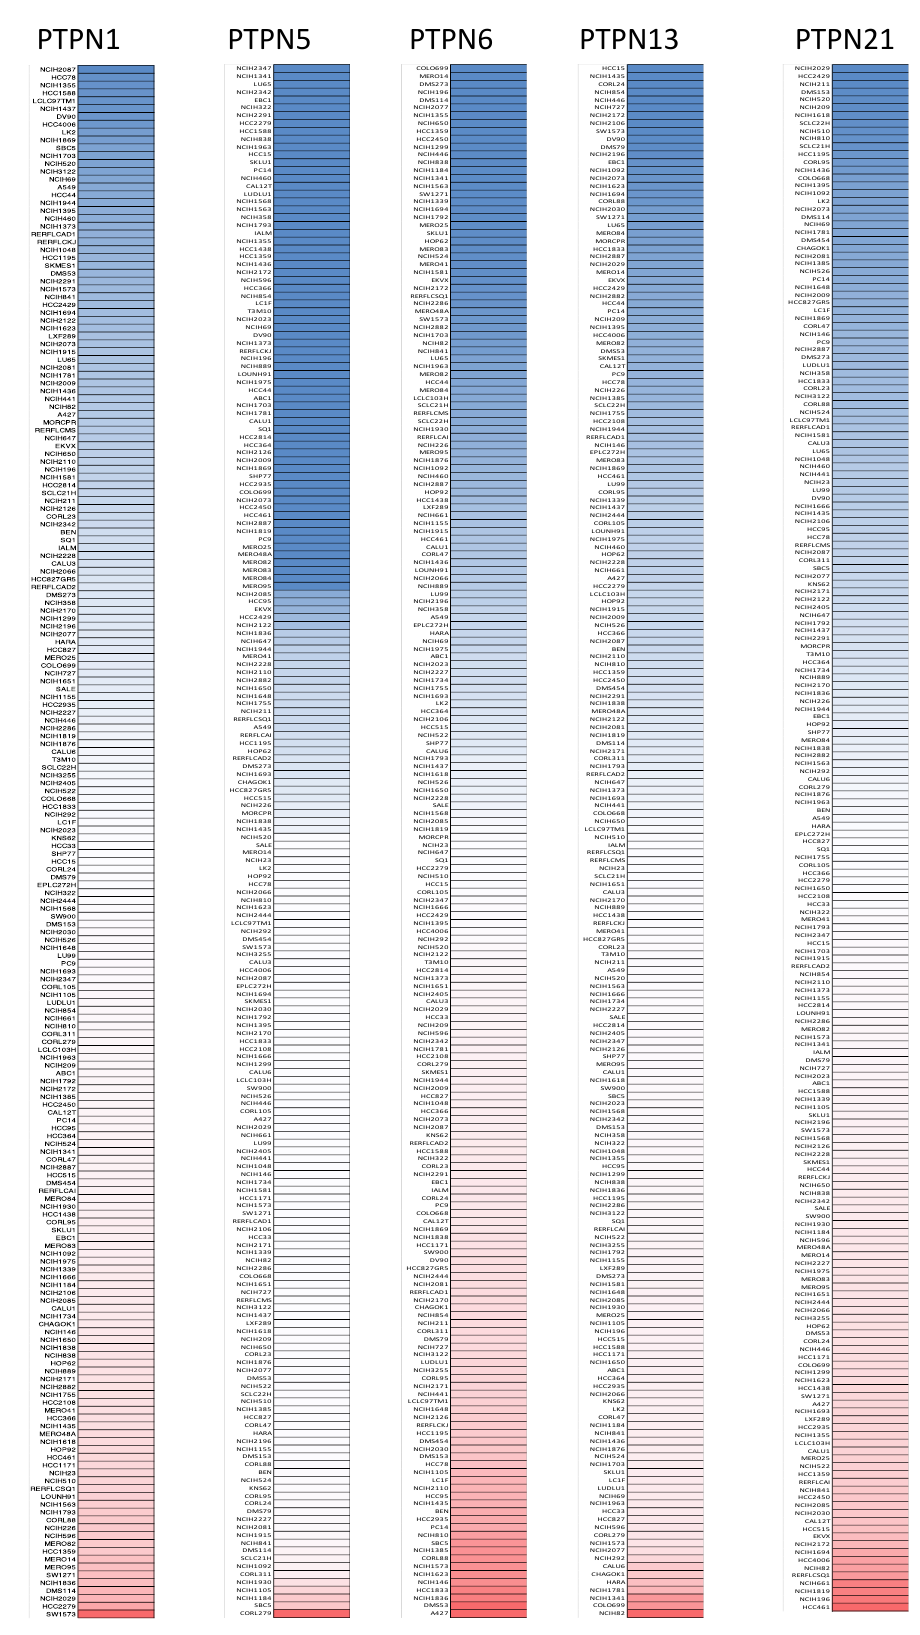
Figure 2. Gene expression levels of protein tyrosine phosphatase non-receptor type ( PTPN ) family members in lung cancer cell lines (from the CCLE database). The blue blocks indicate underexpression, whereas red blocks represent overexpression.